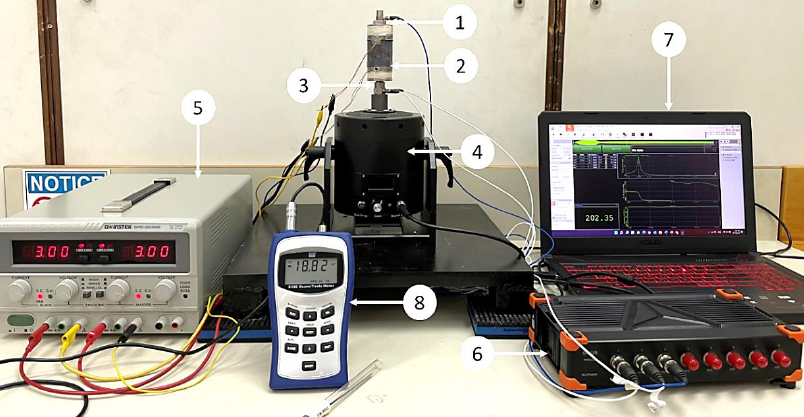
Figure 6. Experimental setup: (1) accelerometer, (2) hybrid MRE-based coupling, (3) impedance sensor, (4) vibration shaker, (5) regulated power supply, (6) data acquisition system, (7) computer with signal analyzing software, and (8) tesla meter.